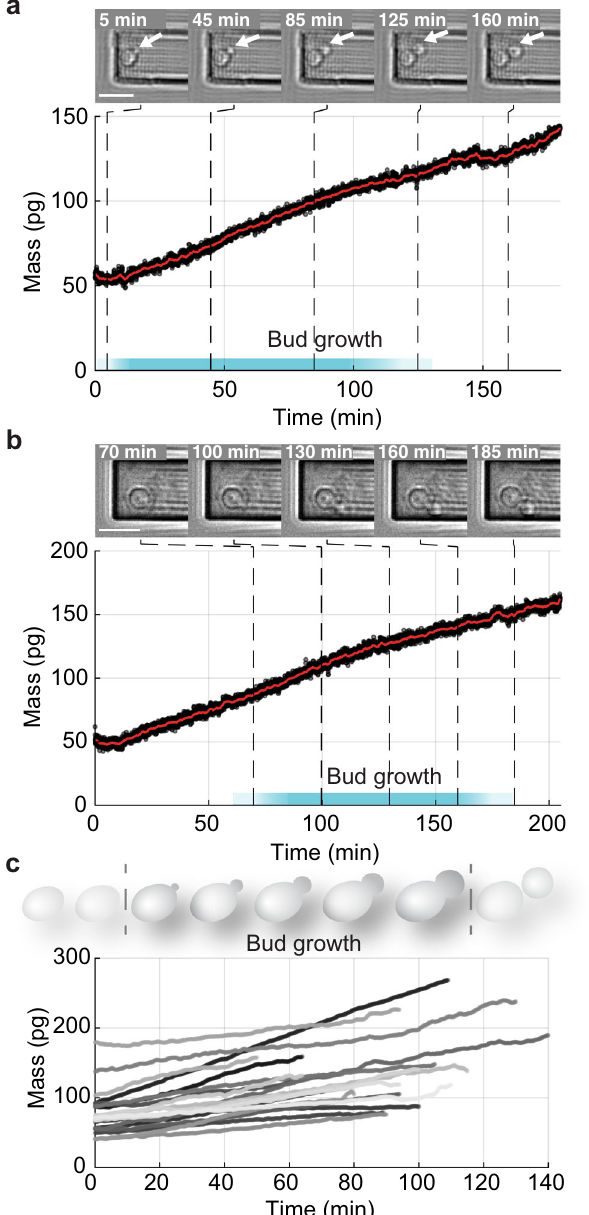
(Fig. 1e) and recording fl uorescence images every 5 min. We introduced this mass measurement mode named “ sweep mode ” to minimize stress on the cell during fl uorescent measurements and to corroborate mass measurements acquired using the continuous mode. The mass resolution using the sweep mode was 11.0 ± 1.4 pg and approached 4.6 ± 0.5 pg upon averaging the data with a sliding window of 350 s (Supplementary Fig. 1d). On average, the noise of mass measurements recorded using the sweep mode was roughly four times higher than in the continuous mode (Supplementary Fig. S1c, d).